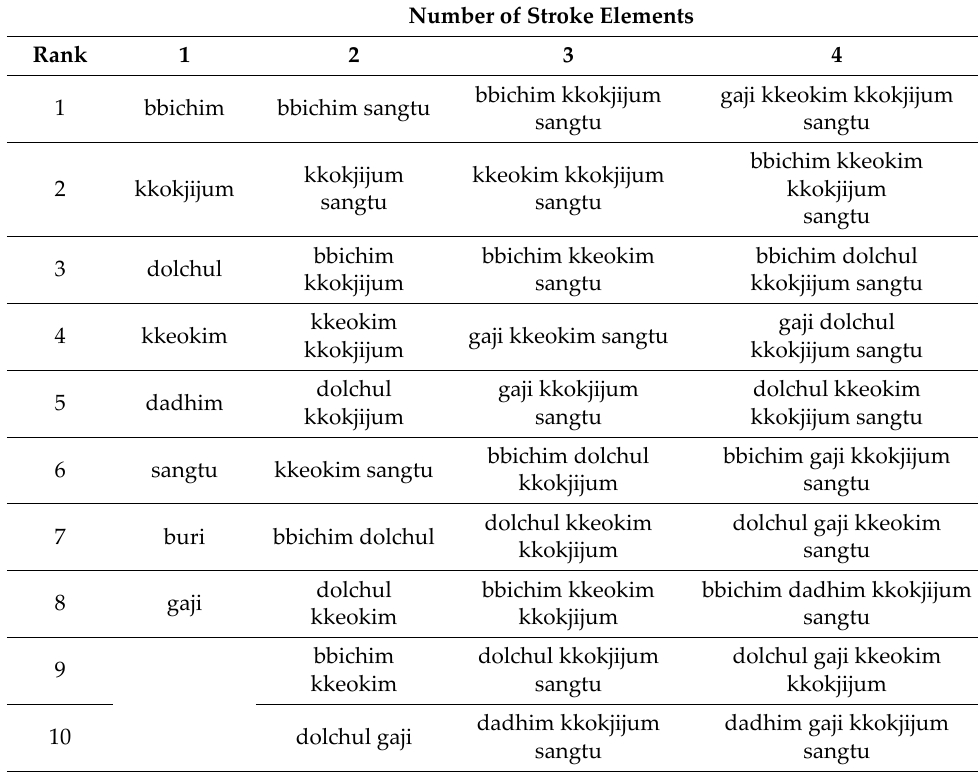
Table 10. Ranking of influence of stroke elements by combination.